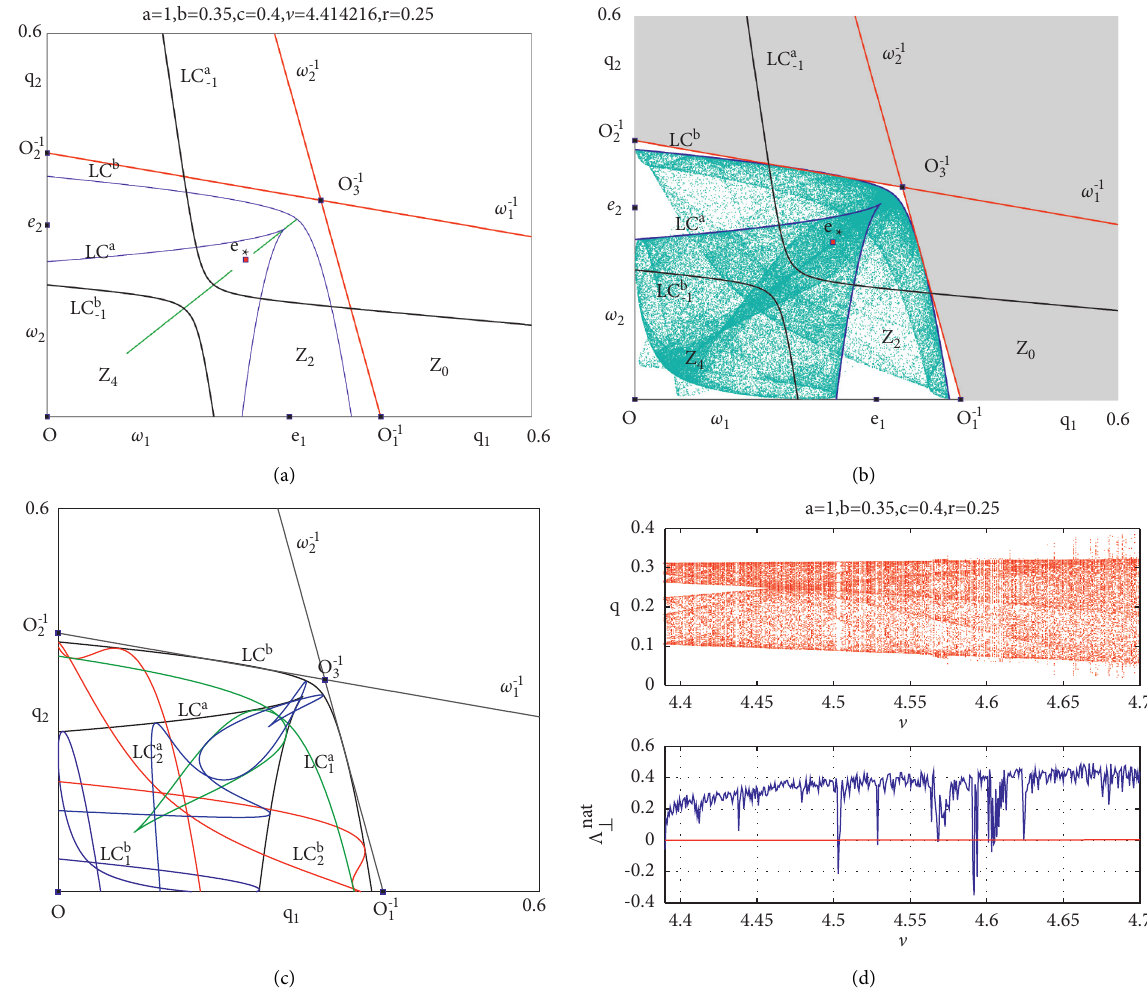
Figure 5: At a � 1 ,b � 0 . 35 ,c � 0 . 4 , r � 0 . 25, the basin of attraction for (a) Milnor attractor, ] � 4 . 414216. (b) One-piece chaotic attractor, ] � 4 . 763885. (c) The boundaries of chaotic attractor in (b). (d) Bifurcation diagram on varying ] and the corresponding transverse Lyapunov exponent for ] ∈ [ 4 . 4 , 4 . 7 ]